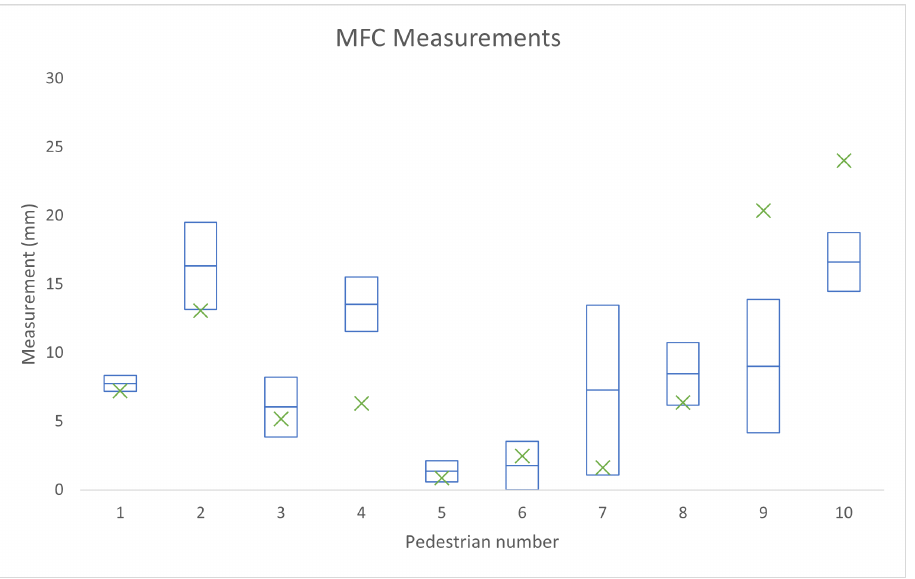
Figure 9. The Manual measurements’ range within one standard deviation of each pedestrian’s respective mean is shown with the blue boxes and the automatic measurement for each case is marked by the green